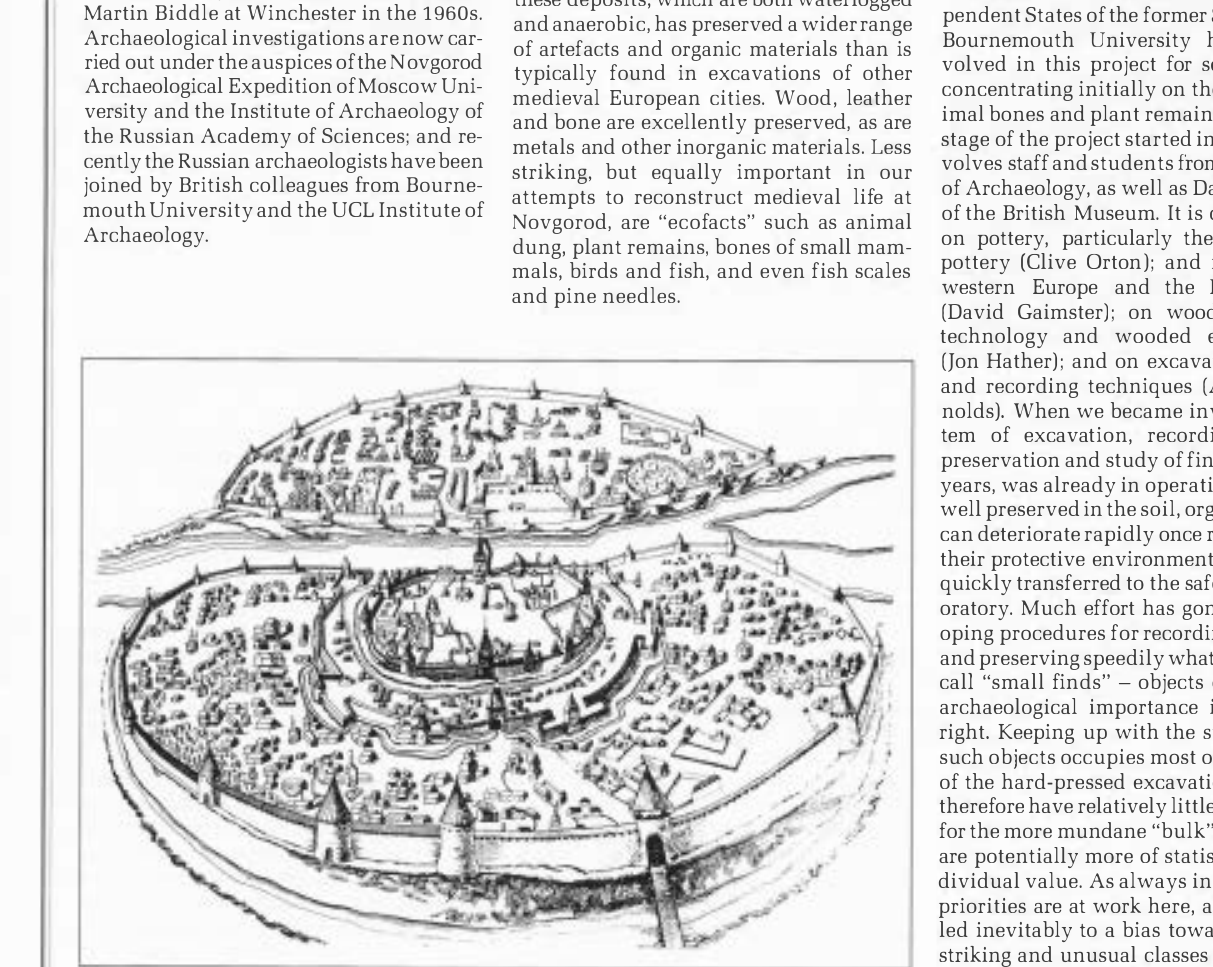
Figure 1 700 (from the frontispiece in Brisbane (ed.) (seen. 1 Medieval Novgorod c. AD